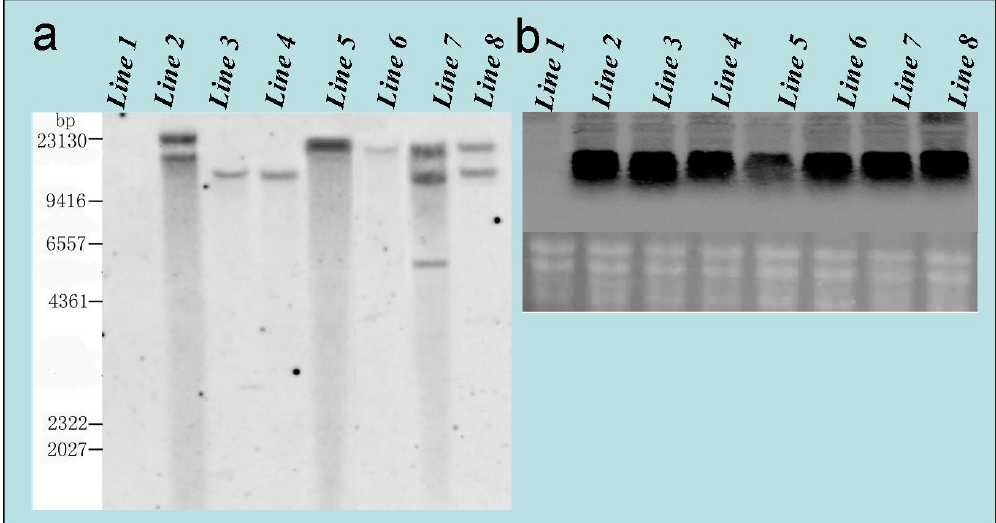
Figure 7 ( a ) Southern blot analysis of transgenic poplar. Poplar DNA was digested with Bam HI, electrophoresed, and probed with DIG-labeled MD–GFP gene. Molecular weight DNA markers were shown on the left. Lane 1: non-transgenic poplar (control), and Lanes 2~8: transgenic poplar lines; ( b ) Detection of the transgene by Northern blot analysis. Analysis of the exogenous MD–GFP expression of the transgenic lines by Northern blot. Lane 1: non-transgenic poplar (control), and Lanes 2~8: transgenic poplar